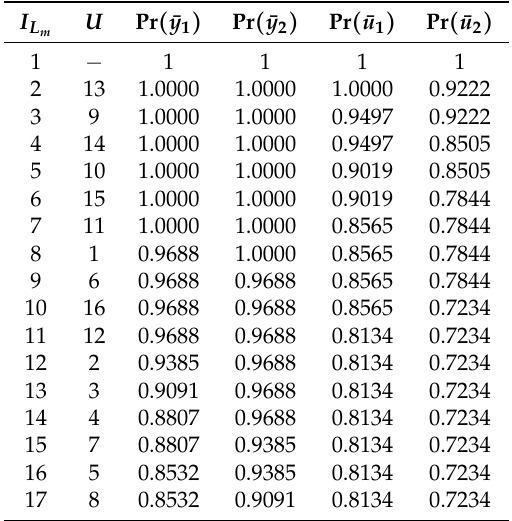
Table 6. Probabilities of successful transmission for each new setting of the network such that the nodes U exchange L ∞ ,5 following the sequence I Lm (Energy for node ∈ { }